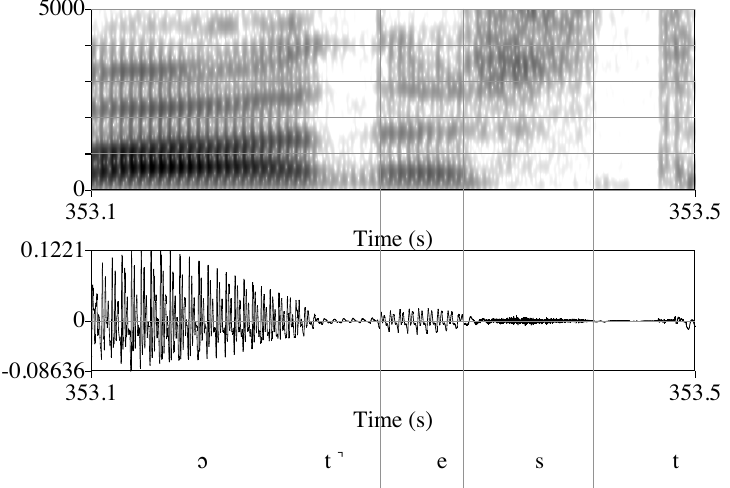
Figure 2 . Measurement of English stimuli with vowel prothesis (He b[ɔt